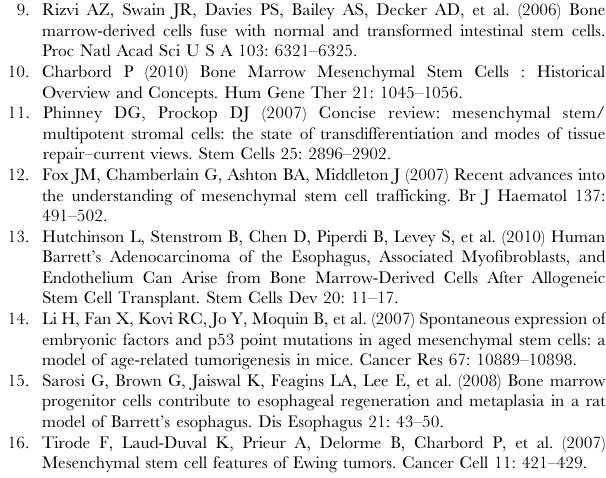
H. pylori infection and effect on MSC migration.